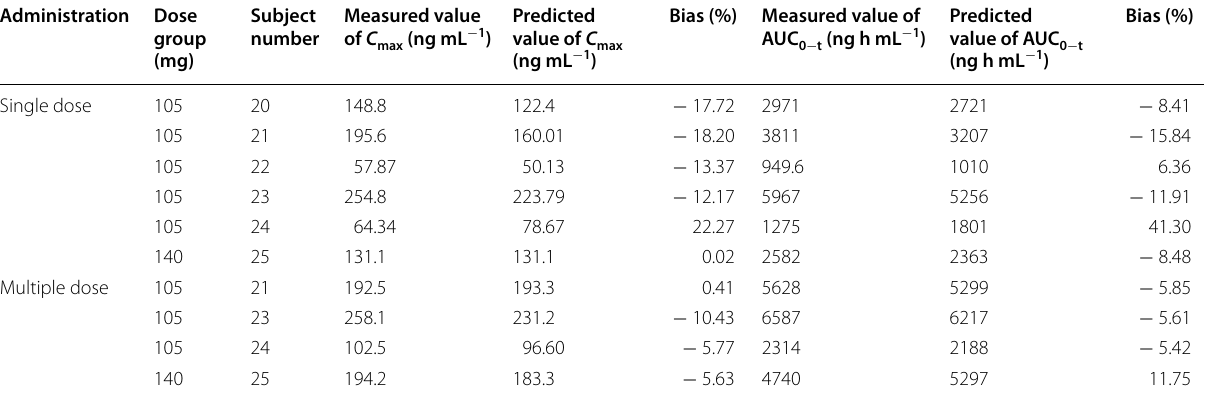
Table 5 The measured and predicted main PK parameters in NSCLC patients after an oral dose of MET306 tablets at different doses Administration Dose